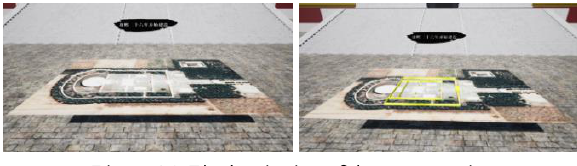
Figure 24. The beginning of the construction Figure 25. Site selection process of Zhaoxi-ling